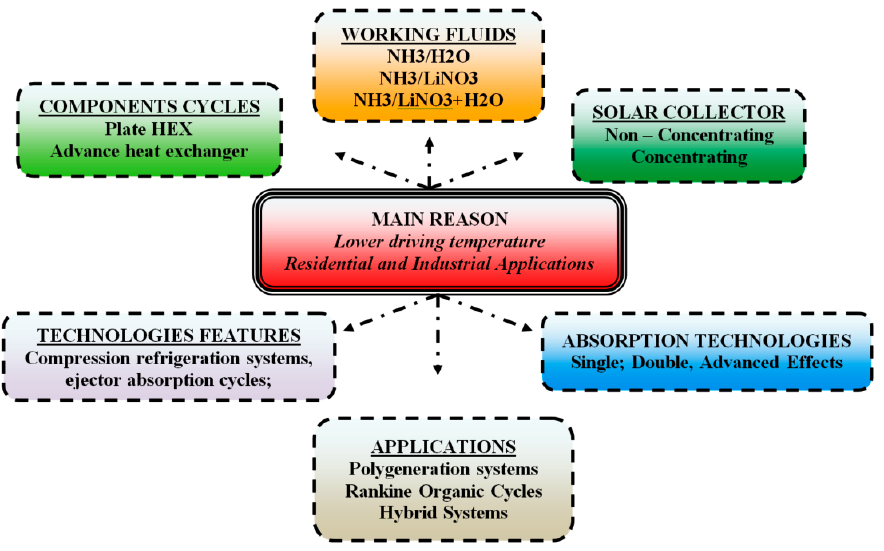
Figure 12. Schematic graphic of the solar energy source to drive absorption systems with ammonia/absorbents.